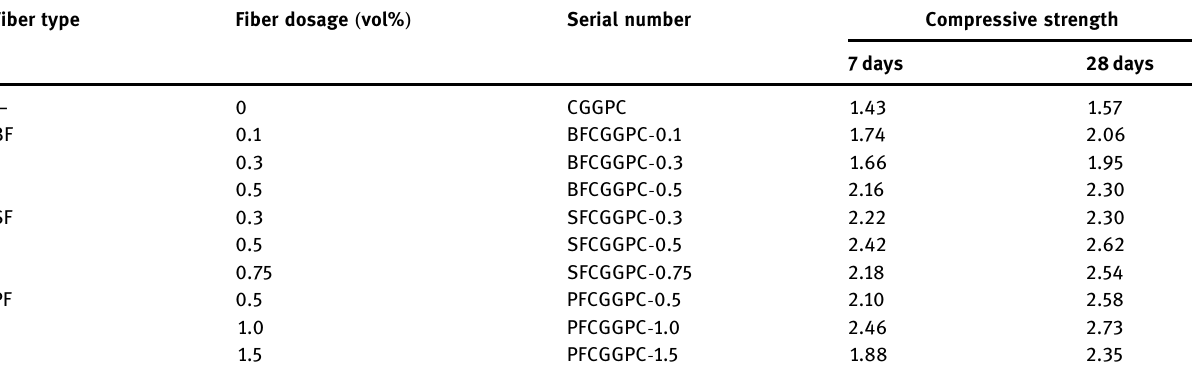
Table 8: Test results of cube splitting tensile strength